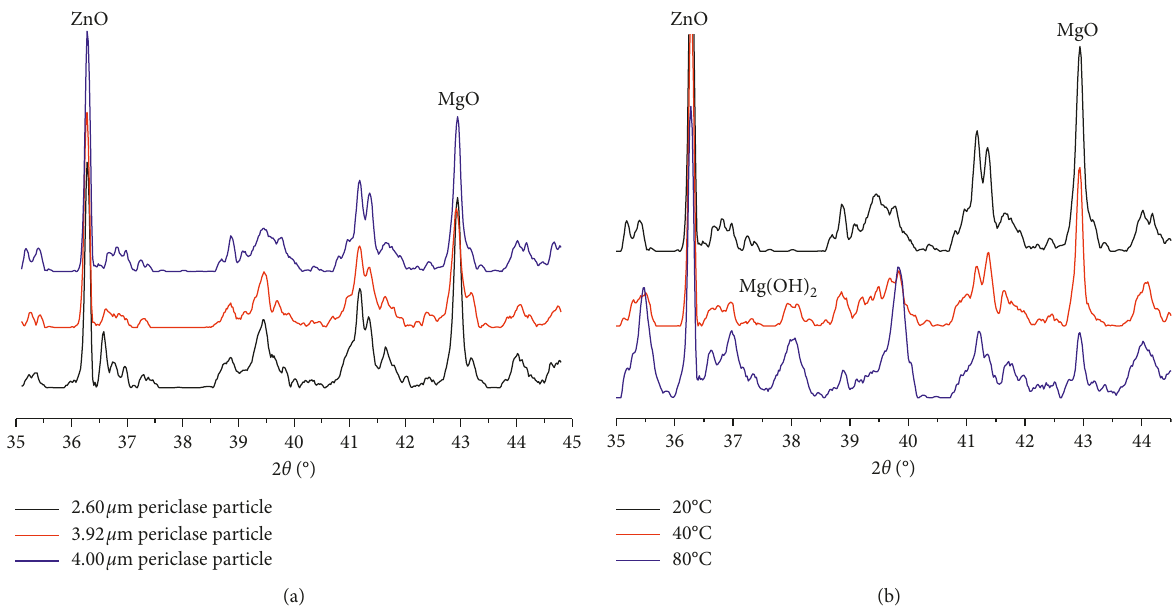
Figure 4: The XRD patterns of cement pastes cured for 240 days at 20 ° C and 80 ° C, respectively. (a) The cement pastes with 2.60, 3.92, and 4.00 μ m periclase particle cured at 20 ° C for 240 days; (b) the cement paste with 4.00 μ m periclase particle cured at 20 ° C, 40 ° C, and 80 ° C for 240 days. Table 4: Hydration degree of periclase in LHC cement pastes cured for 7, 28, 60, 90, 180, and 240d (%). The hydration degree of periclase Particle size of periclase ( μ m) Curing temperature, T ( ° C)